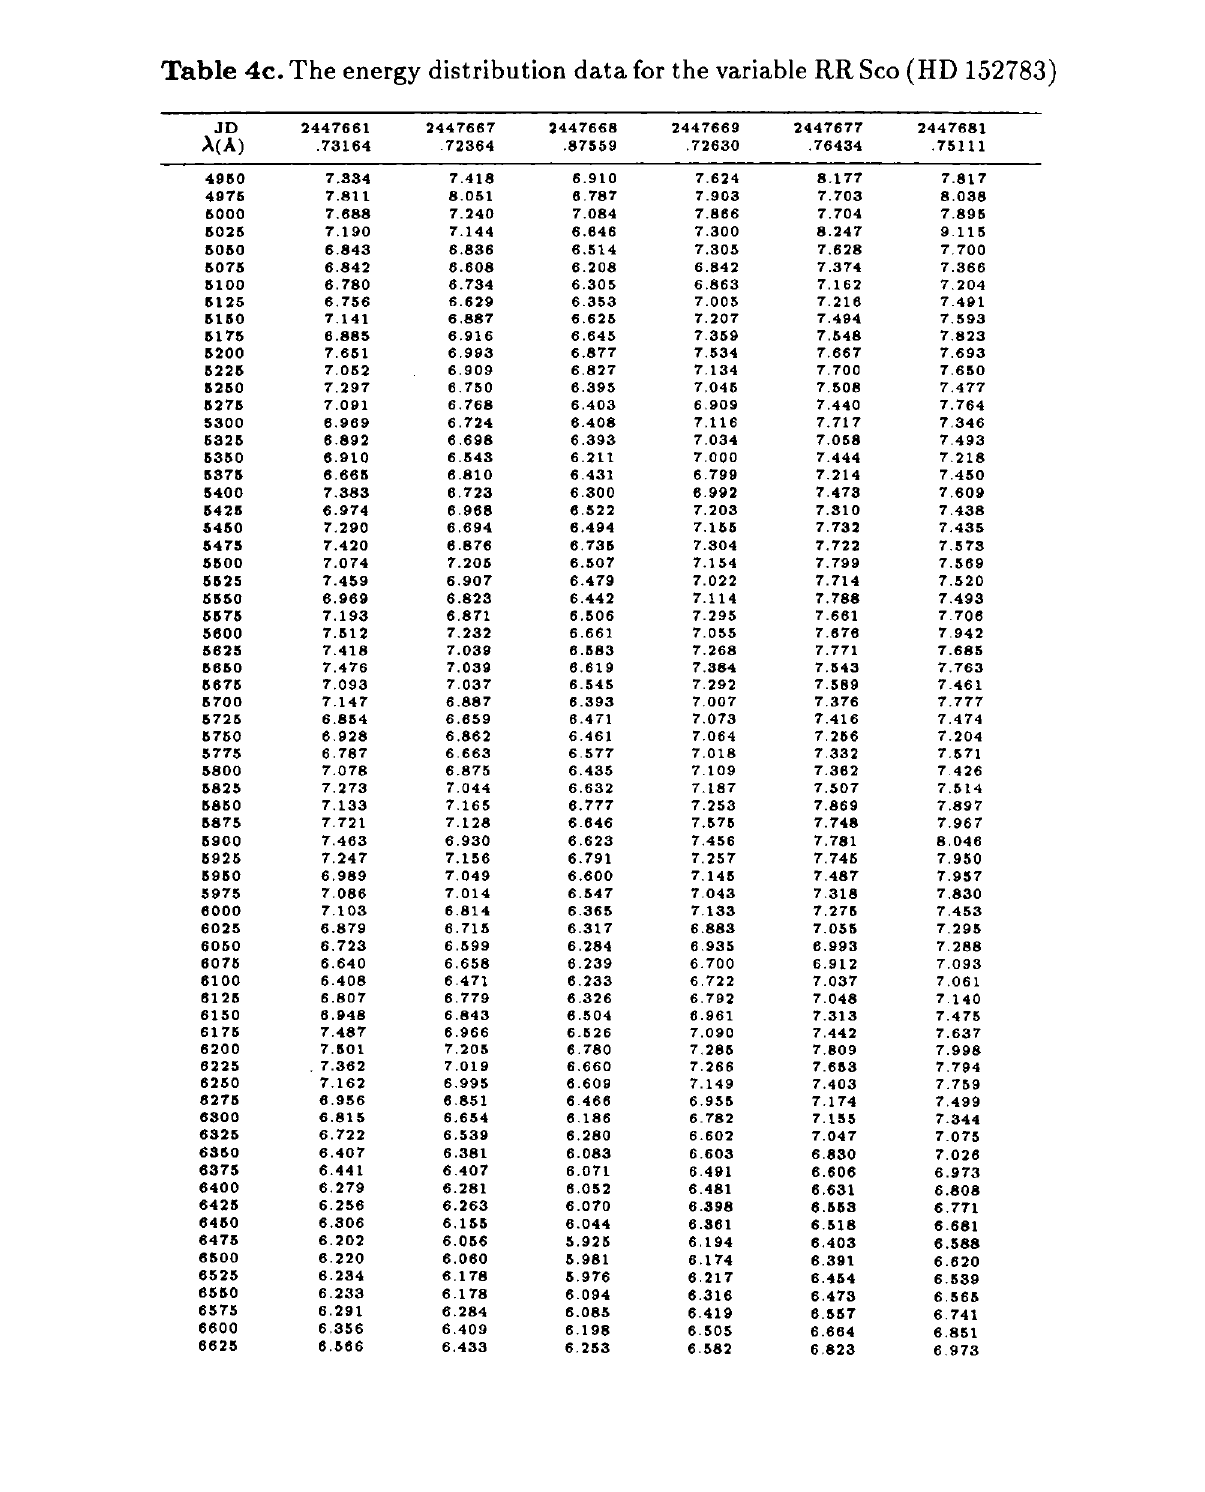
Table 4c. The energy distribution data for the variable RR Seo (HD 152783)